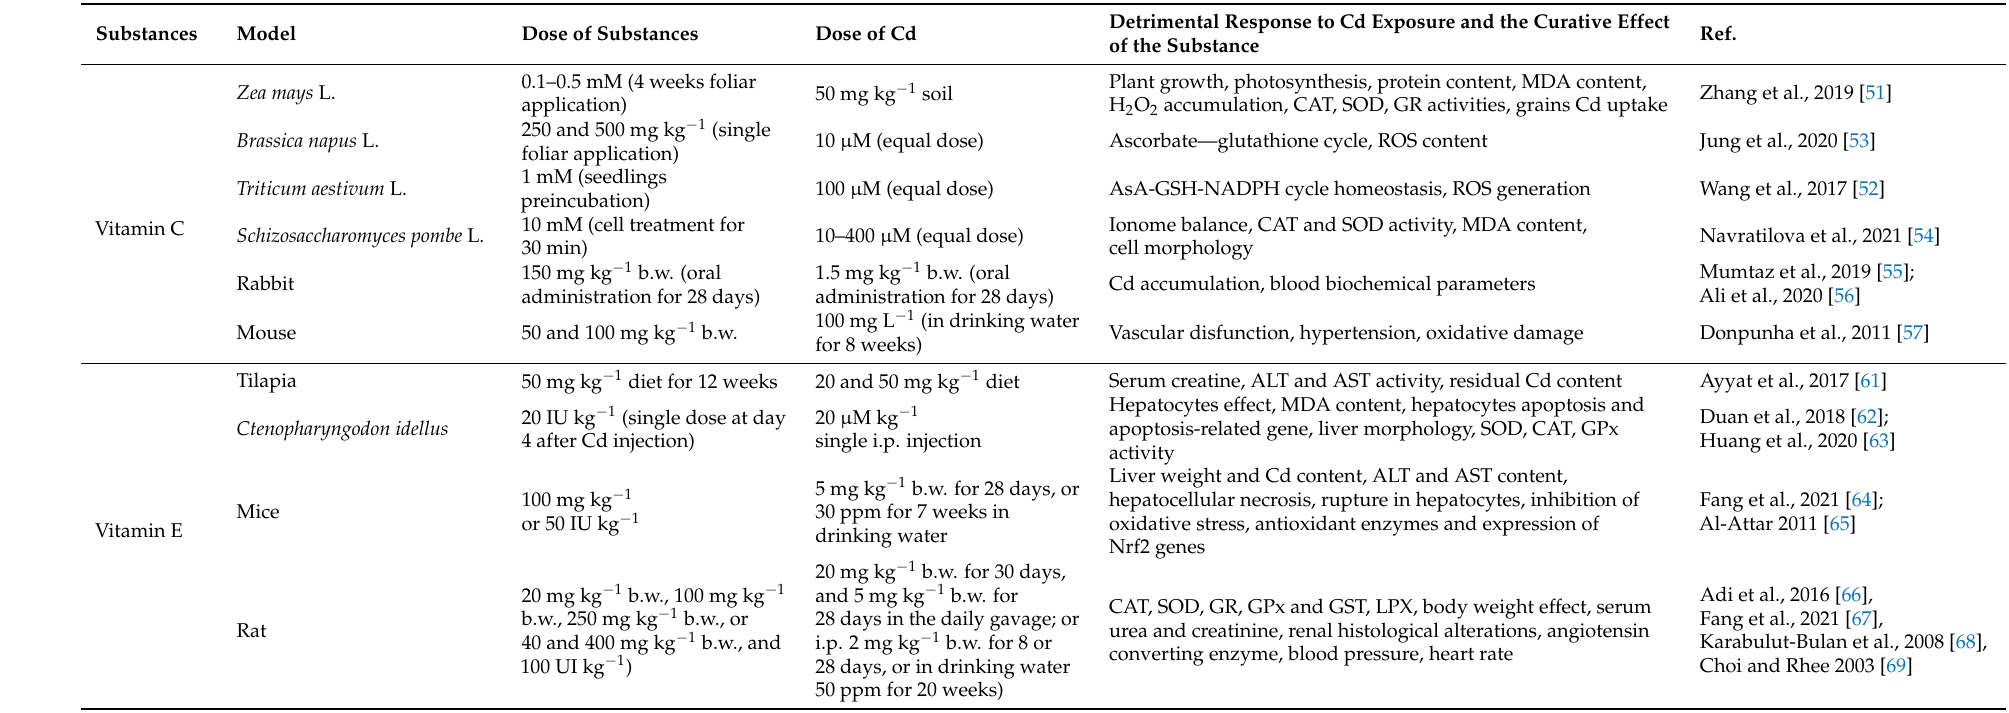
Table 1. Effects of